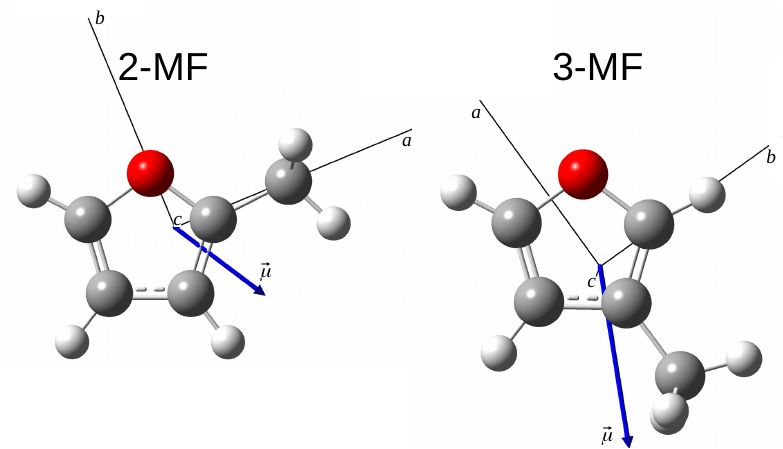
Figure 1. Optimized geometries of the 2-MF and 3-MF isomers determined at the B3LYP/aug-cc- pVTZ level of theory. The axes are the principal axes of inertia. The blue arrow is the permanent electric dipole